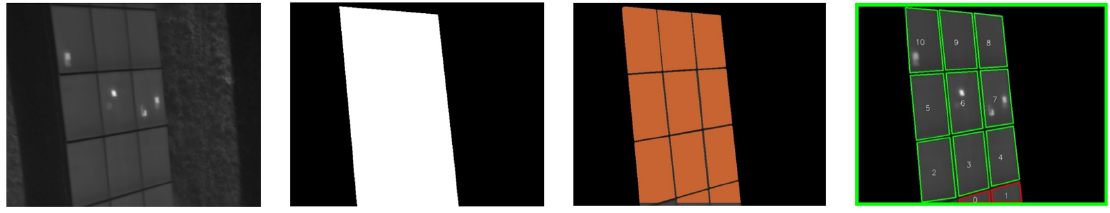
Figure 11. Individual panel detection and